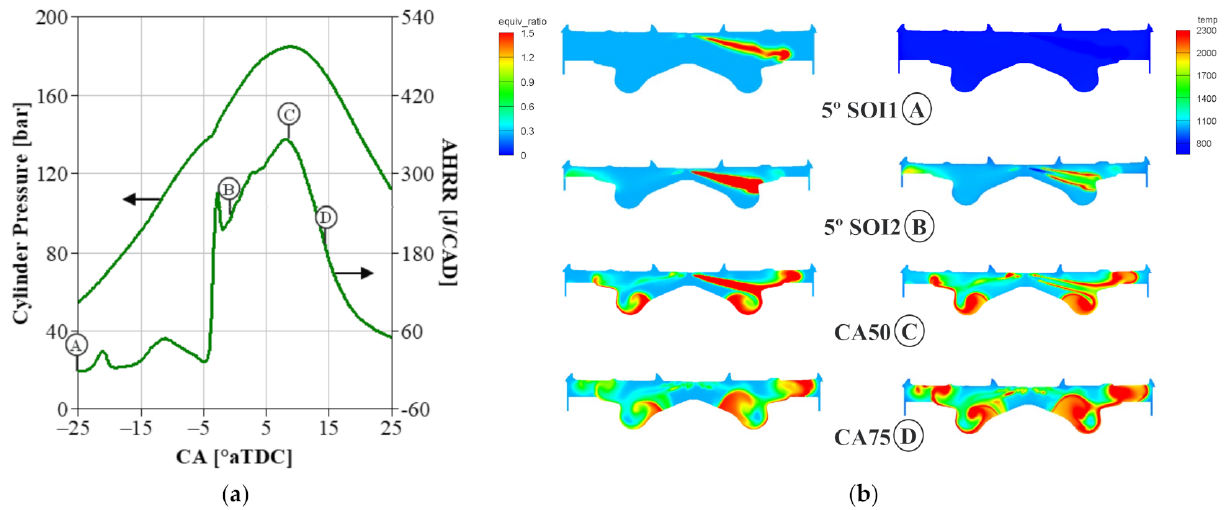
Figure 10. In-cylinder GCI combustion behavior at B75 predicted by 3D CFD: ( a ) Pcyl and AHRR; ( b ) cross-sectional equivalence ratio and temperature contours.